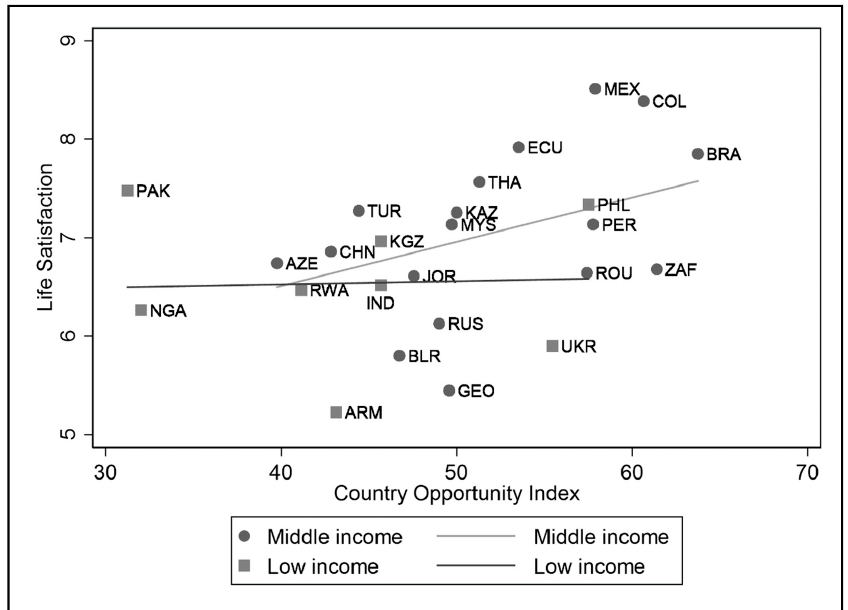
Figure 2. Life satisfaction versus Opportunity Index, source: authors’ calculation, abbreviation for countries available in Table A2.